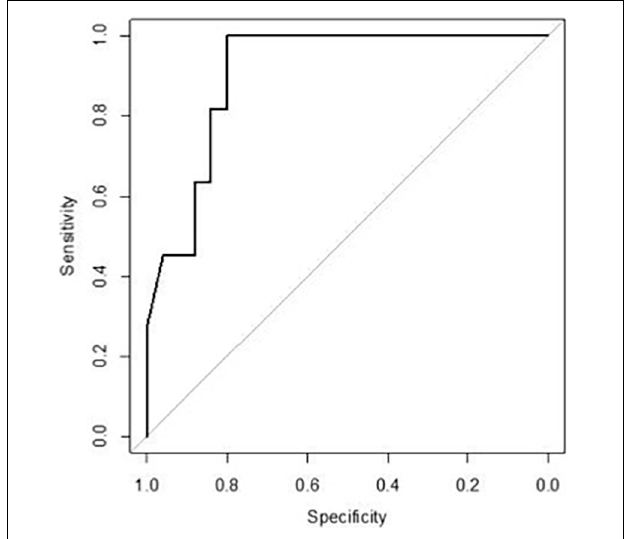
FIGURE 4 | A receiver operating characteristic (ROC) curve of TNF fold increase on day